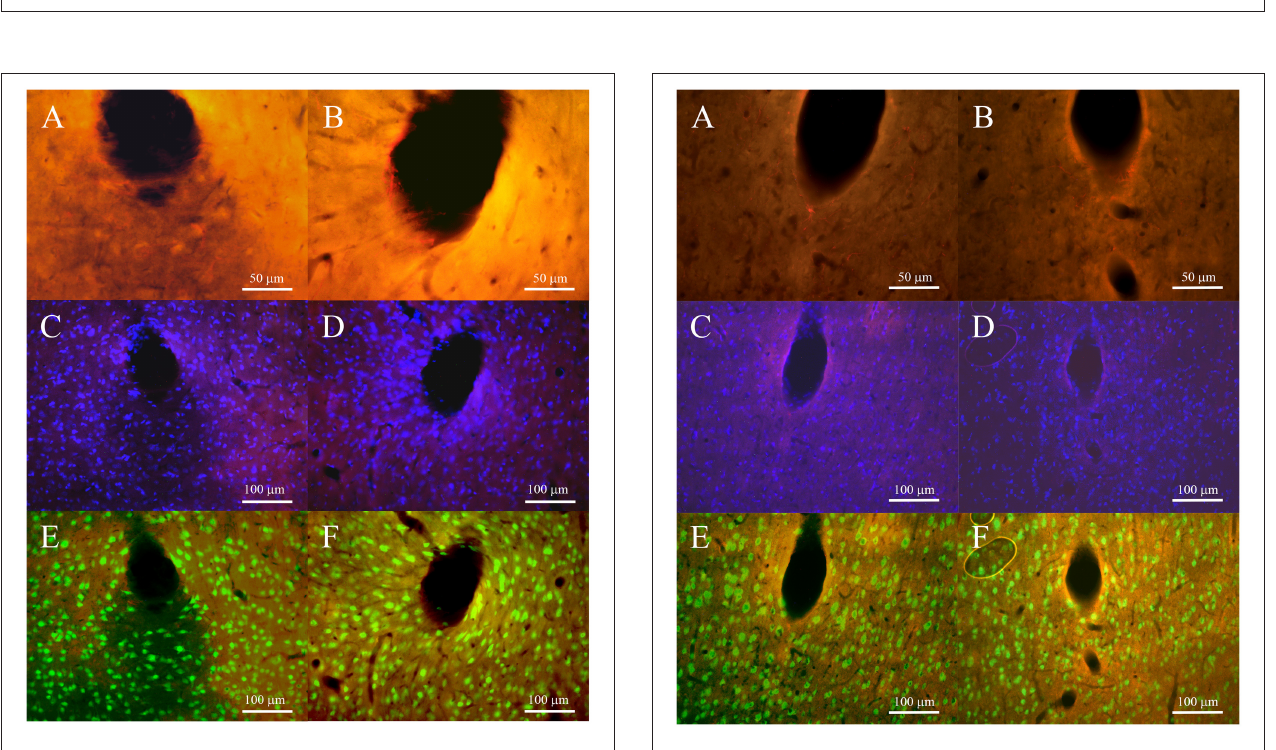
FIGURE 10 | Fluorescence microscopy images of tracks for non-encapsulated (left panels) and pHEMA-encapsulated (right panels) microspheres 4 weeks after implant. (A,B) show the GFAP-positive cells (red) at 40 × to underline the morphology of astrocytes; (C,D) cell nuclei (blue) superimposed on GFAP staining to verify the density of DAPI surrounding the tracks; (E,F) neuron nuclei (green) superimposed on GFAP to show the presence of neuronal bodies surrounding the